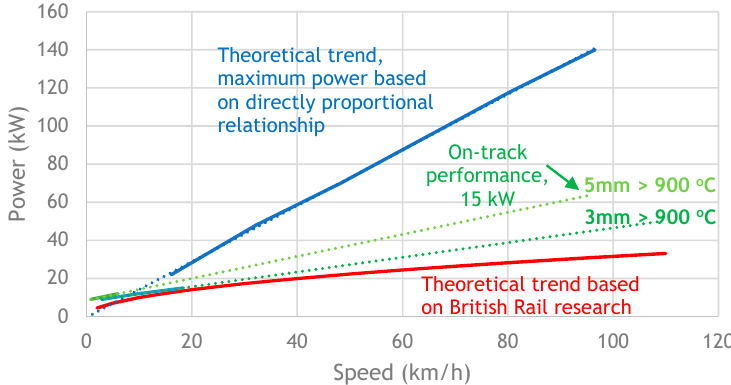
Figure 12. Power vs. speed extrapolation based on on-track real condition testing results .